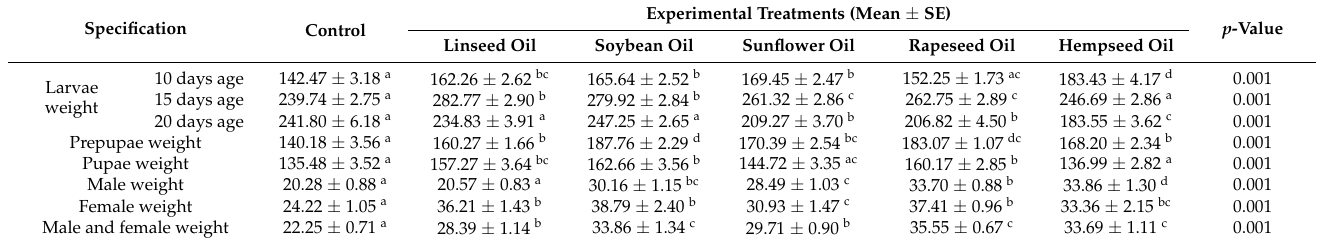
Table 1. The effects of vegetable oil addition on the larvae diets on the evolution of body weight in the developmental stages of Hermetia illucens .